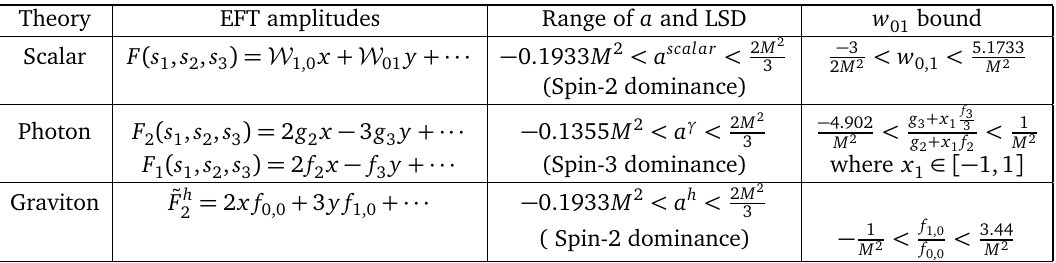
Table 1: Example of two sided bounds we have found for scalars, photons and gravi- tons using